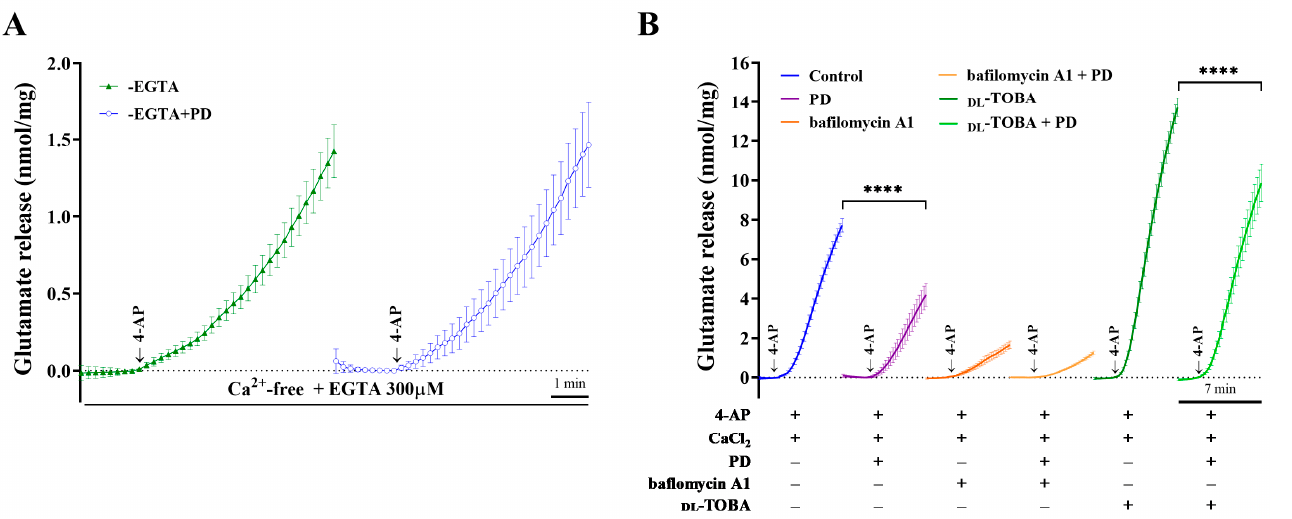
Figure 3. Determining the effects of the Ca 2+ chelator EGTA, the nonselective glutamate transporter inhibitor DL -TBOA, and the cellular autophagy inhibitor bafilomycin A1 on the inhibitory effect of PD. ( A ) Ca 2+ deprivation induced by excluding Ca 2+ and the addition of EGTA, a Ca 2+ chelator, showed no effect on PD-mediated inhibition of glutamate release. Each point represents data collected at 2 s intervals. For clarity, only the time point and error bars every 10 s are shown. ( B ) Isolated synaptosome were divided into 6 experimental groups as follows: (i) control, (ii) PD, (iii) bafilomycin A1, (iv) bafilomycin A1 + PD, (v) DL -TBOA and (vi) DL -TBOA + PD. It shows the inhibitory effect